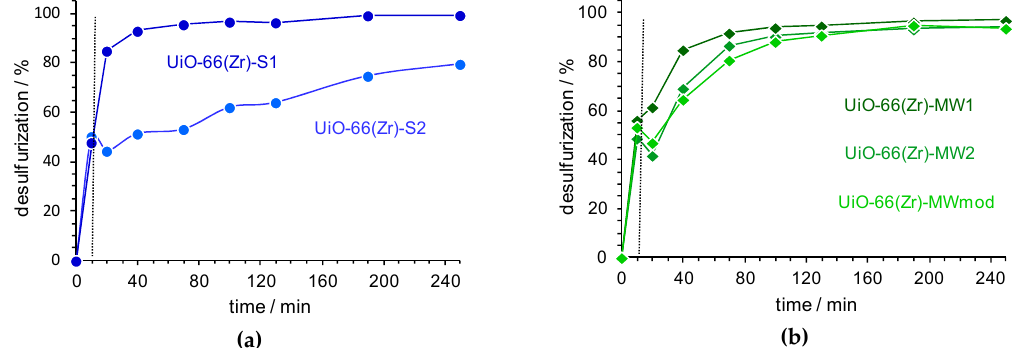
Figure 4. The desulfurization profiles using a biphasic model diesel / MeCN (1:1) system and H 2 O 2 as an oxidant (H 2 O 2 / S = 13), at 50 ◦ C: using UiO-66(Zr) catalysts prepared by the solvothermal method UiO-66(Zr)-S1 and S2 ( a ) and by MWAS UiO-66(Zr)-MW1, MW2 and MWmod ( b ). The vertical dashed lines indicate the beginning of the catalytic step in the extractive and oxidative desulfurization (ECODS) process by adding the oxidant.